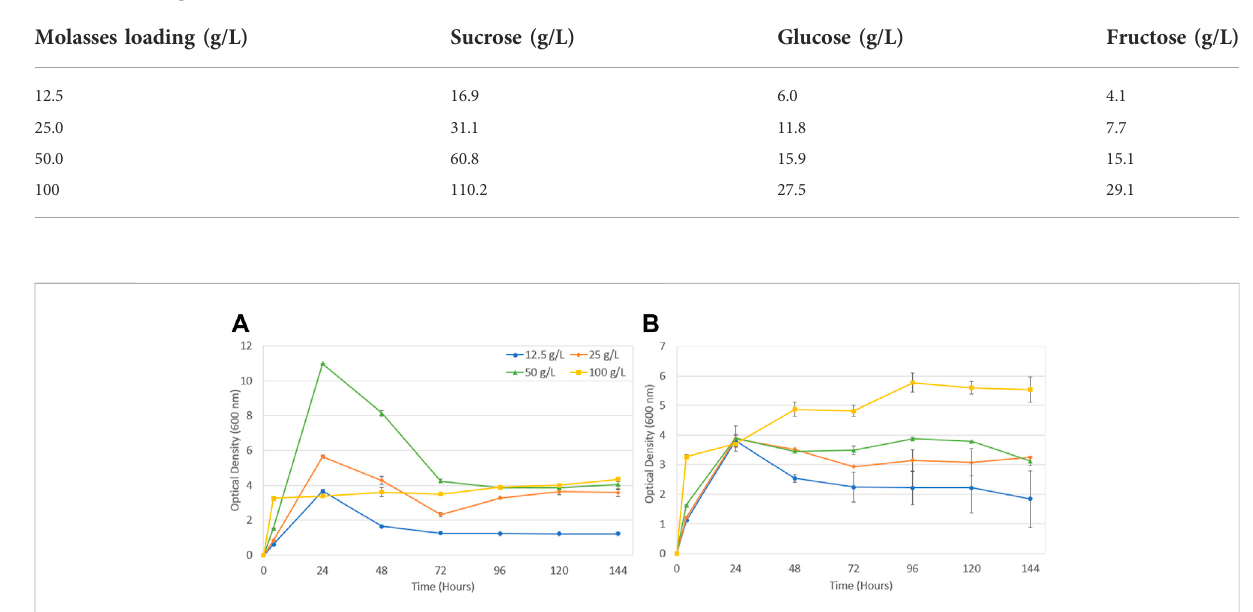
TABLE 1 Initial sugar concentrations for molasses media.